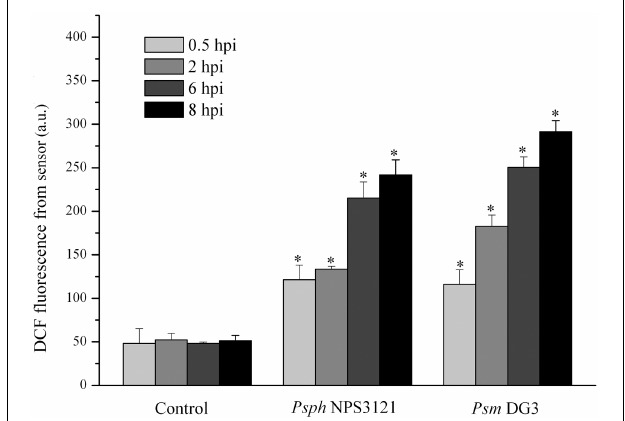
FIGURE 4 | A series of unknown concentrations of Pseudomonas syringae pv . tomato DC3000 ( Pst DC3000) were used to infect A. thaliana leaves. Dichlorofluorescein (DCF) fluorescence was measured at 6 hpi. The concentration of Pst DC3000 was measured by conventional methods based on the culture and colony-counting method following 48h of proliferation as described in the Materials and Methods. The mean ± SD of the fluorescence intensity represents the amounts of pathogen in five independent A. thaliana leaves. A.U., arbitrary unit; cfu, colony-forming units; hpi, hour post inoculation.